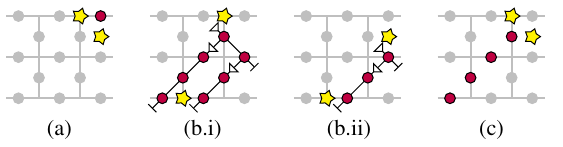
FIG. 24. Example of candidate Y -type recovery operator con- struction for a square code using partial recovery operators. (a) Original error and complete syndrome. (b) Partial recovery operators with residual boundary syndrome locations. (c) The candidate recovery operator is the product of all partial recovery operators, since residual boundary syndrome locations cancel in the case of square